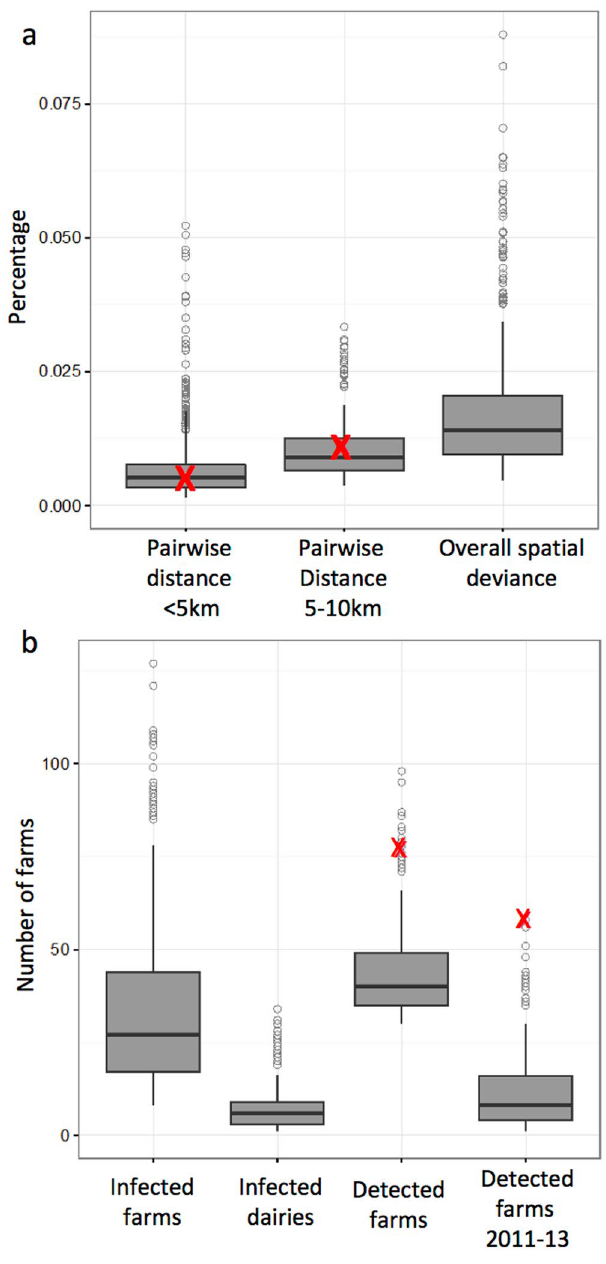
Figure 3. Summary of the epidemiological dynamics of simulations run with the fitted parameters in terms of ( a ) the proportion of pairwise distances between infected farms that are 0–5 and 5–10 km apart, as well as the percent spatial deviance in simulated epidemics, and ( b ) total number of infected farms, infected dairies, detected farms (overall: 2008–2013), and detected farms (2011–2013, the time period used for model parameterization). “X”s represent the observed data. No observed data are shown for infected farms because the true number of infected farms in the population is not